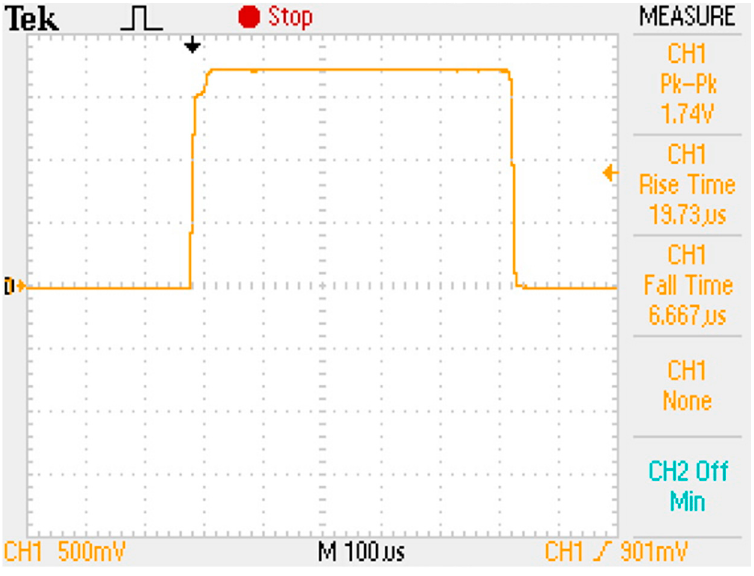
Figure 11. Measured slew rate of 0.07 V/ μ s, rise time of 19.73 μ s, and fall time of 6.67 μ s at an operating frequency of 1 kHz.